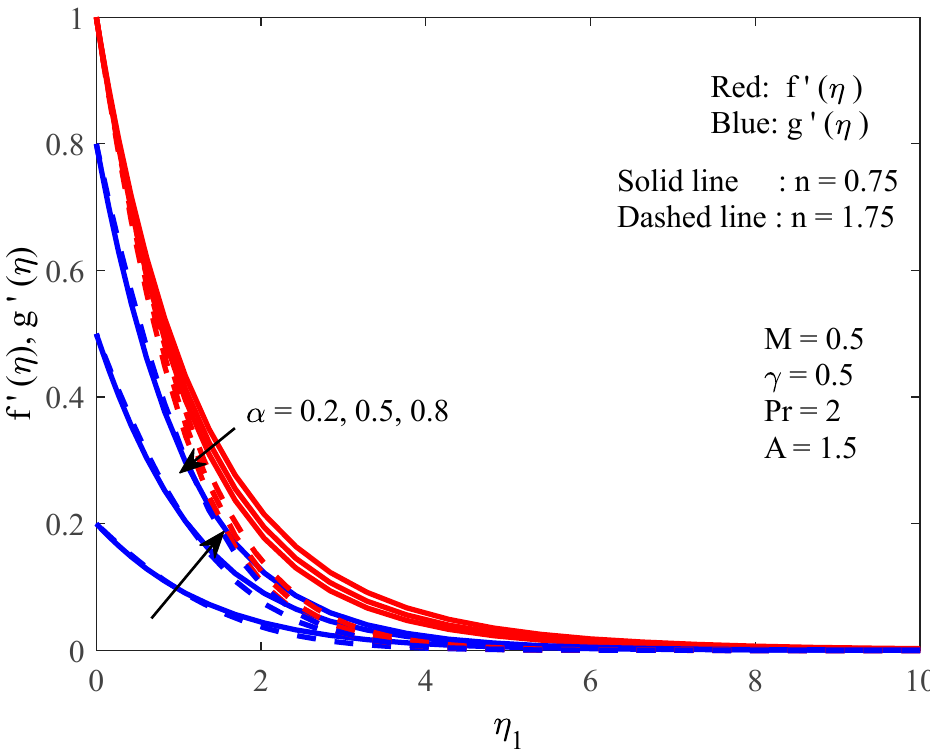
Figure 4. The bidirectional (axial and transverse) velocity distribution profile with the influence of α .